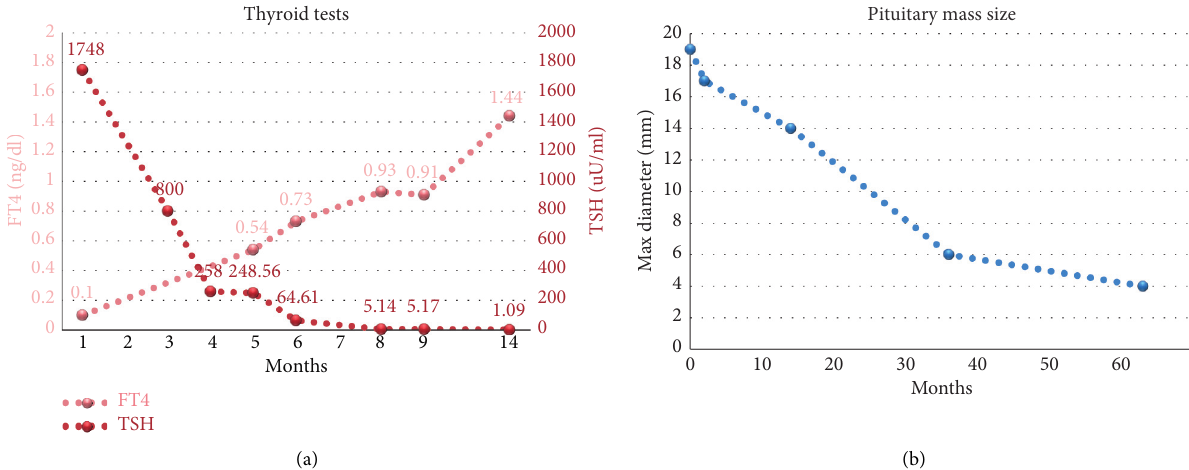
Figure 1: Biochemical and radiological follow-up. (a) TSH and FT4 values during levothyroxine treatment titration. (b) Reduction of the pituitary mass size during levothyroxine treatment, in a follow-up of around 5 years. Table 1: Pituitary (pseudo) macroadenoma secondary to primary hypothyroidism: literature